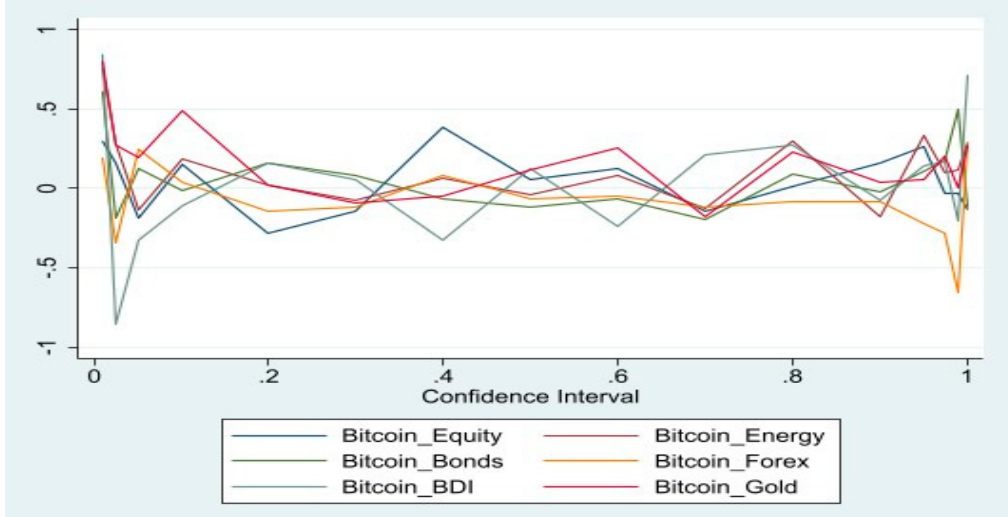
Figure A2. Dynamic conditional correlation—Bitcoin with all assets (DCC-GARCH). Note: The graph in Figure A2 suggests that Bitcoin exhibits negative dynamic conditional correlation at low confidence intervals (negative price development of the reference asset) with a considerably low to negative correlation with all assets during normal price evolution. This indicates that Bitcoin may serve as a potential diversifier, while it may also have some potential properties ranging between a hedge and a safe haven; however, this property appears to dissipate with a slight change in the market conditions.